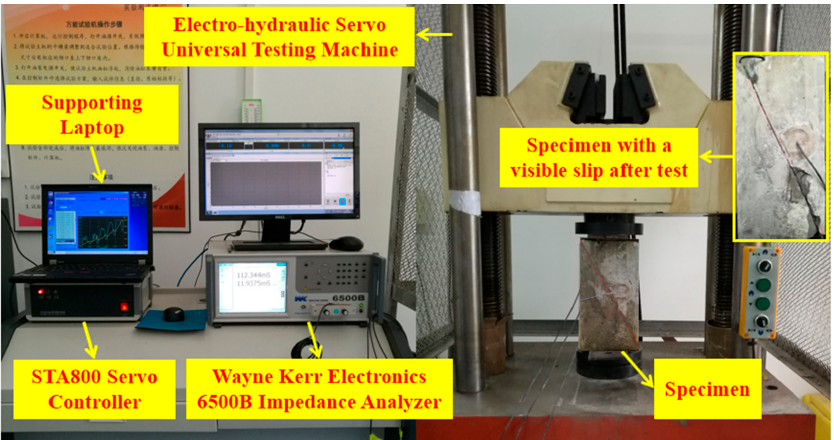
Figure 4. Overall experimental setup.